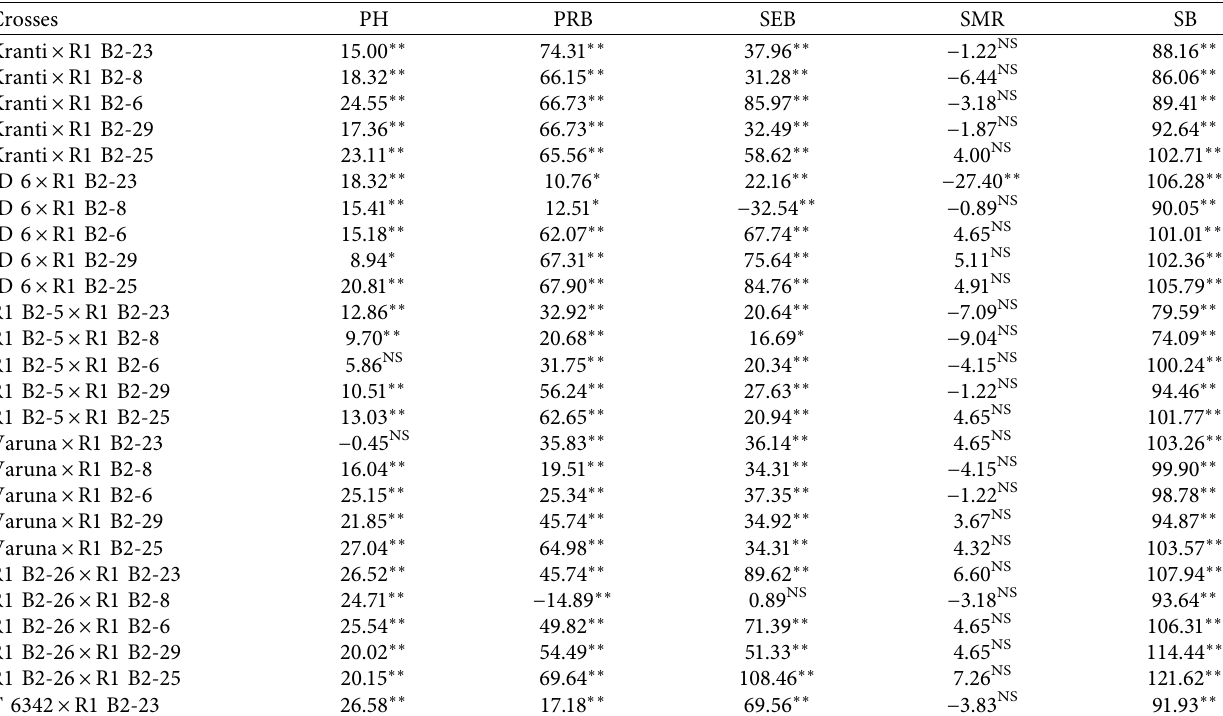
Figure 1: Proportional contribution of lines, testers, and their interactions to total variance. Table 16: Standard (economic) heterosis of mustard hybrids for yield and its attributed